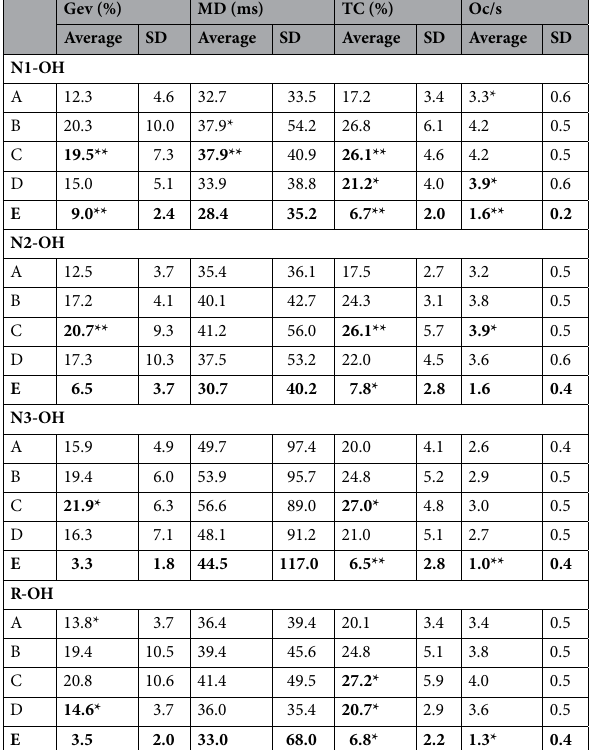
Sleep stage Groups C TC E TC E oc